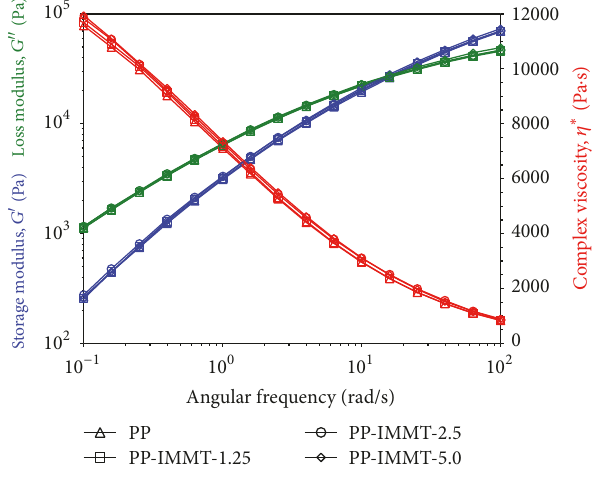
Figure 8: Rheological analysis of PP-IMMT